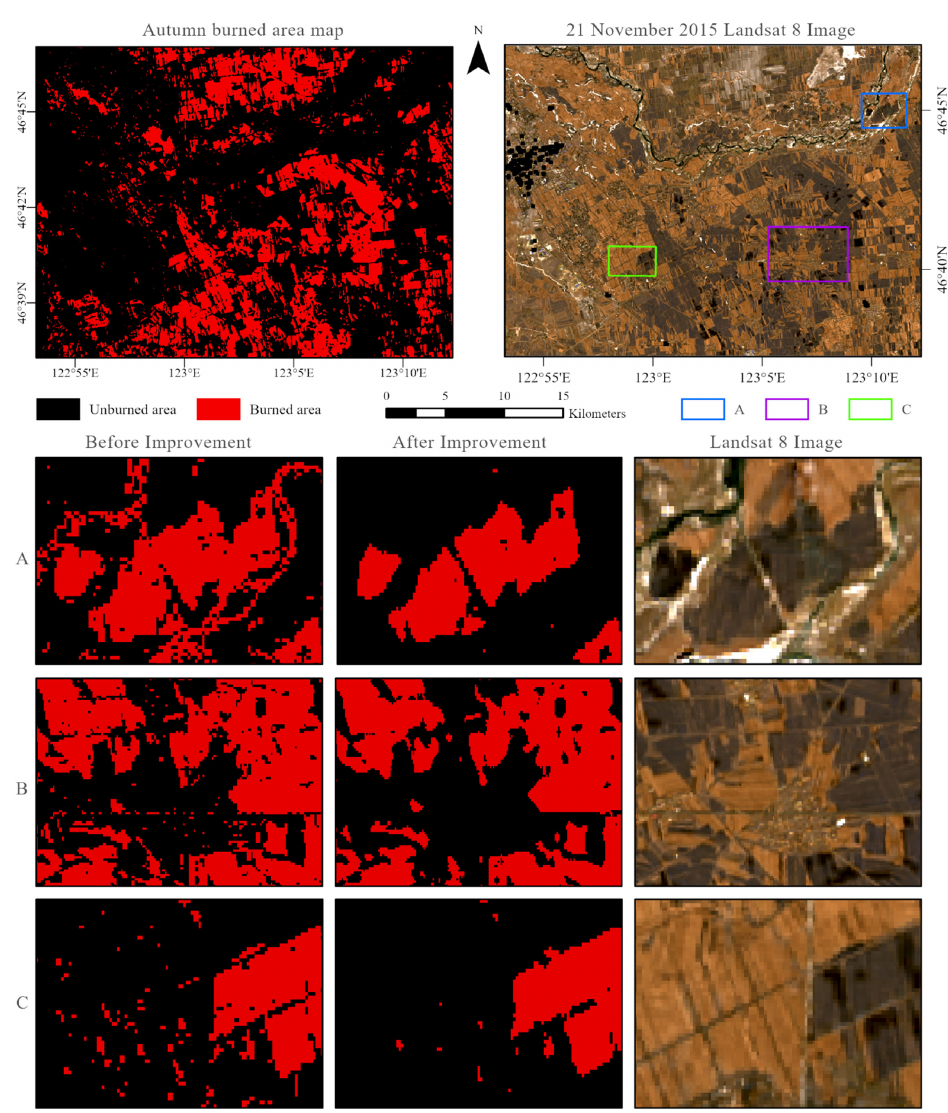
Figure 7. Accuracy improvement via land cover mask and spatial information.